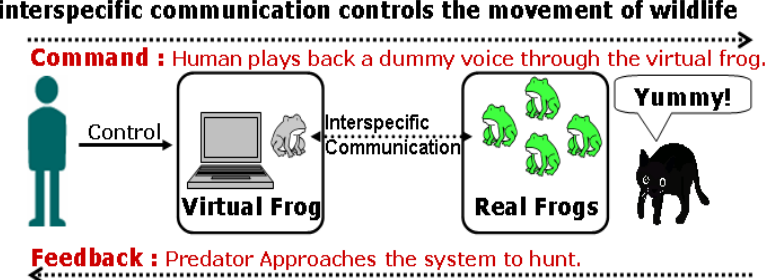
Figure 10. Bio-acoustical interaction instigated to control the behavior of a target